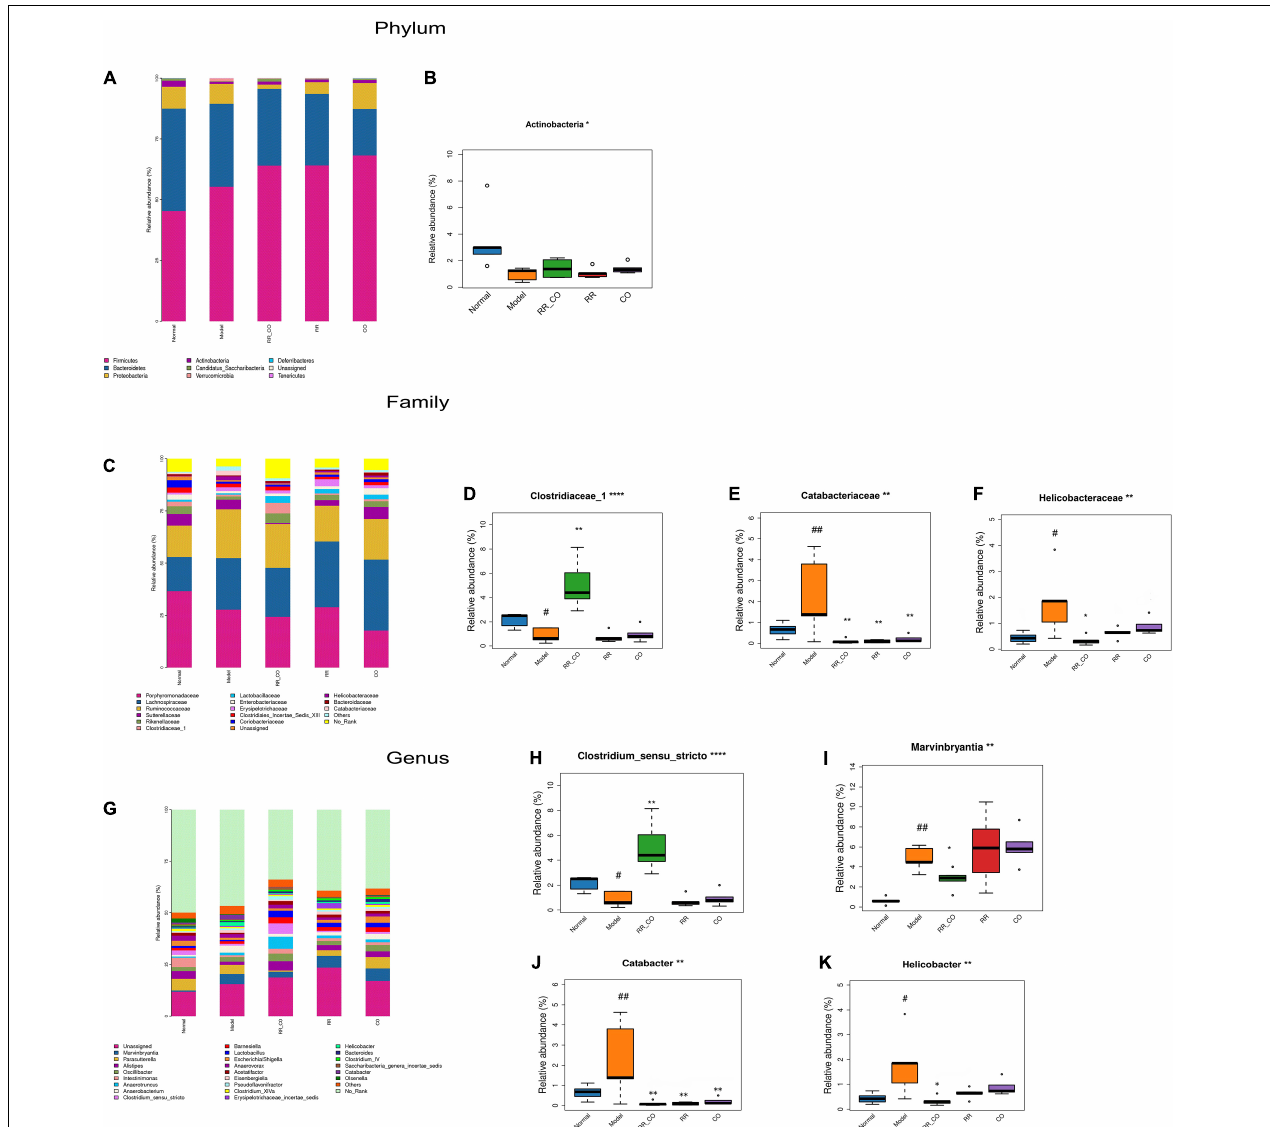
FIGURE 4 | The effects of RR-CO on the abundance of GM in DM mice. (A,B) The relative abundance of the main phyla of GM in different groups. (C–F) The relative abundance of the main families of GM in different groups. (G–K) The relative abundance of the main genus of GM in different groups. Data are expressed as mean ± SD. # P < 0.05; ## P < 0.01 vs. normal group. * P < 0.05; ** P < 0.01 vs. model group; n =